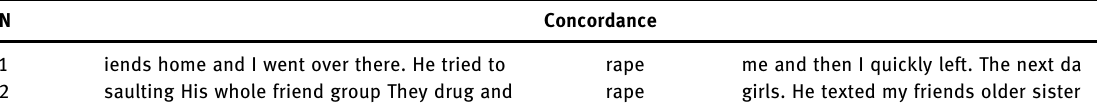
Table 35: Concordance lines for rape